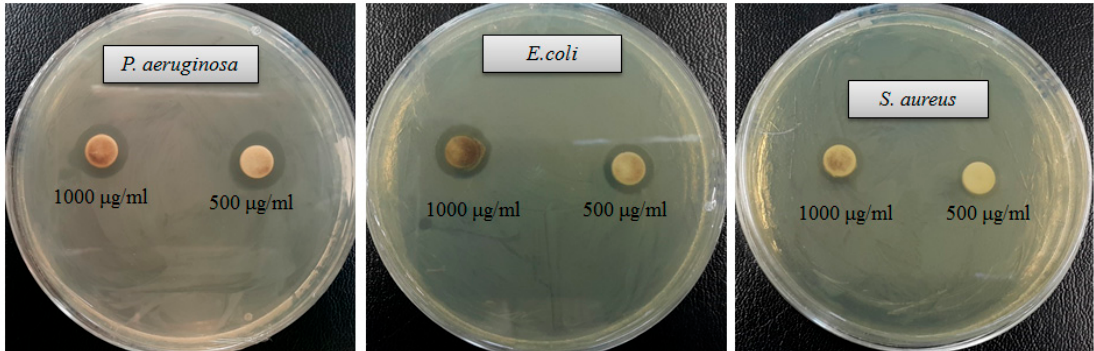
Figure 7. Zones of inhibition of synthesized AgNPs (0.03 mL) at 500 μ g/mL and 1000 μ g/mL concentrations in water against Pseudomonas aeruginosa, Escherichia coli and Staphylococcus aureus .